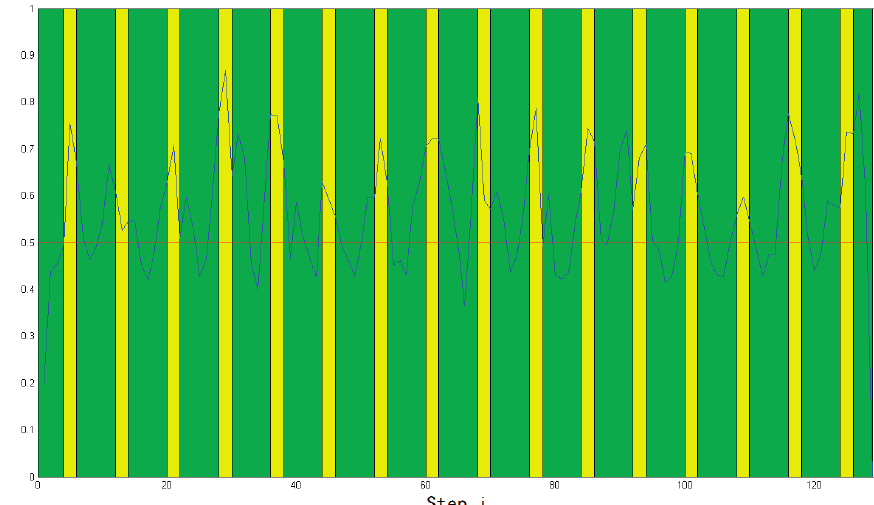
Figure 20. Means and variances of the nine algorithms.